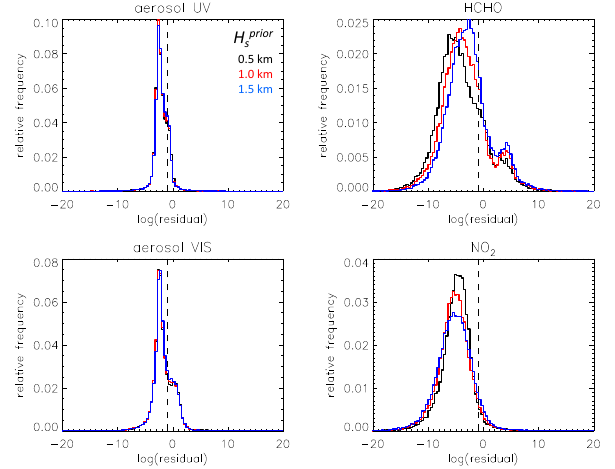
Figure 4. Histograms of residuals of the profile fits obtained with methods A1–A3, based on all MAX-DOAS scans analysed for the Xianghe station. The upper row shows results for the UV, the bottom row shows results for the Vis. The dashed line indicates the thresh- old (0.1, or − 1 on a logarithmic scale) that is used for the quality control: retrievals with residuals above this threshold are excluded from the comparison.